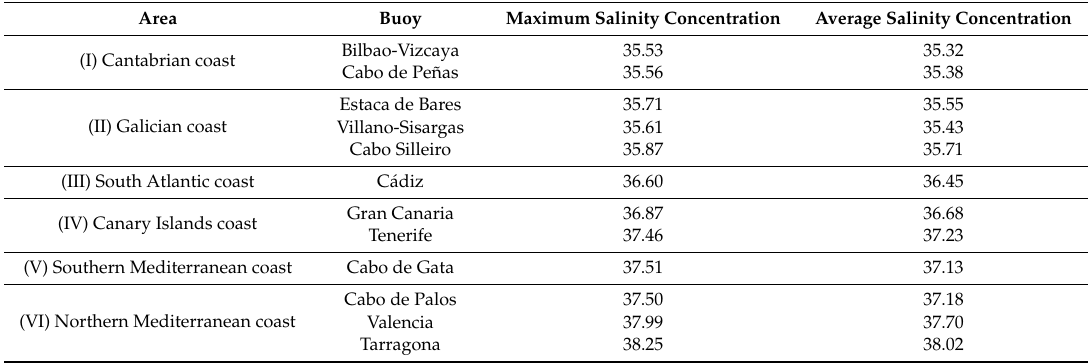
Table 6. Salinity concentration, in parts per thousand, in “Puertos del Estado” buoys, in all the areas in the Spanish coast.